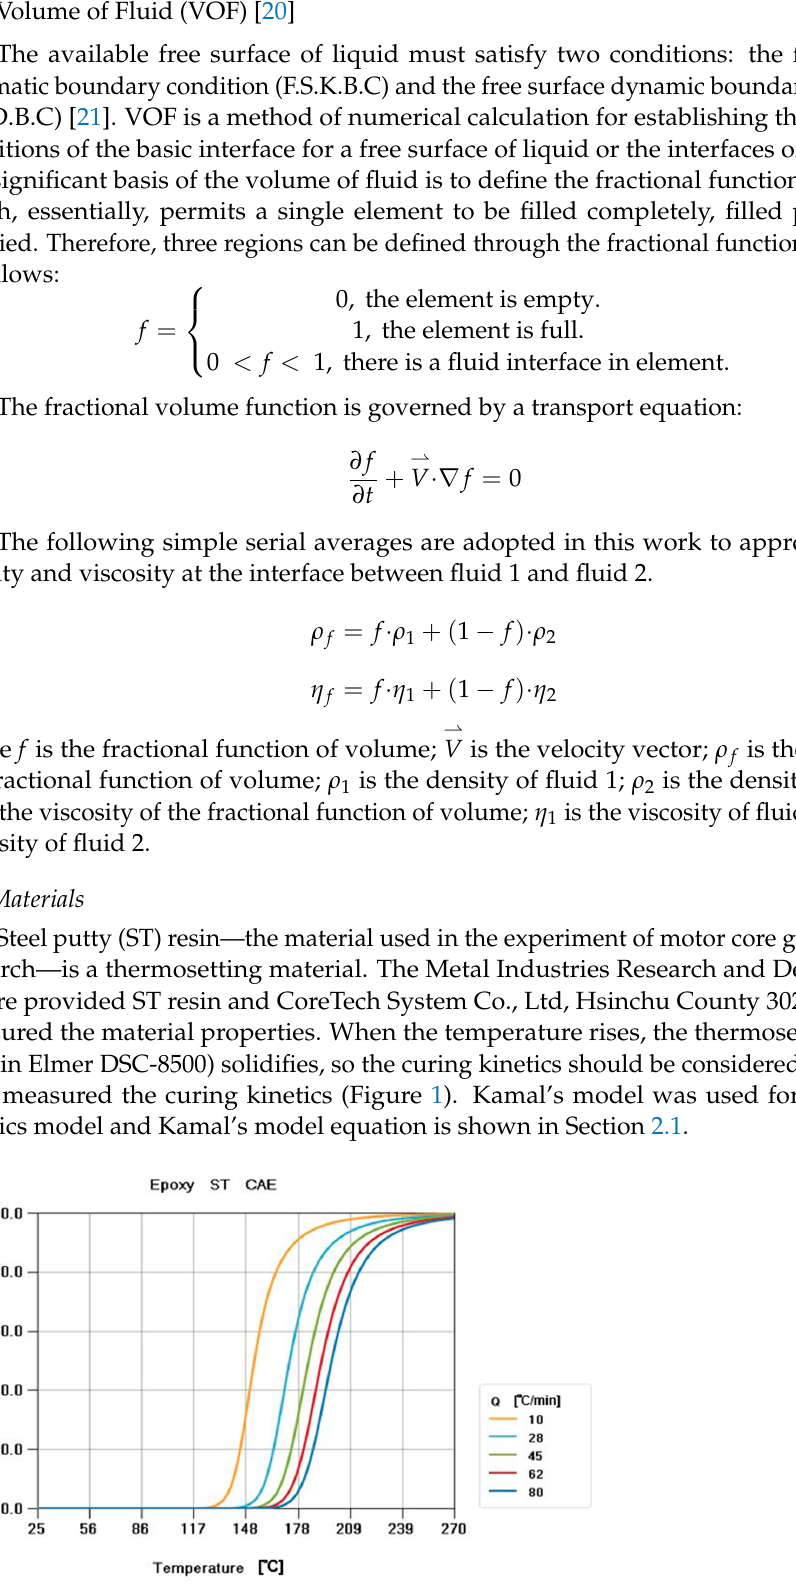
Figure 1. Curing kinetics’ curve of the ST resin. The curing kinetics were measured by a DSC at different temperature ramping rates (Q = 10 °C/min; 28 °C/min; 45 °C/min; 62 °C/min; and 80 °C/min).